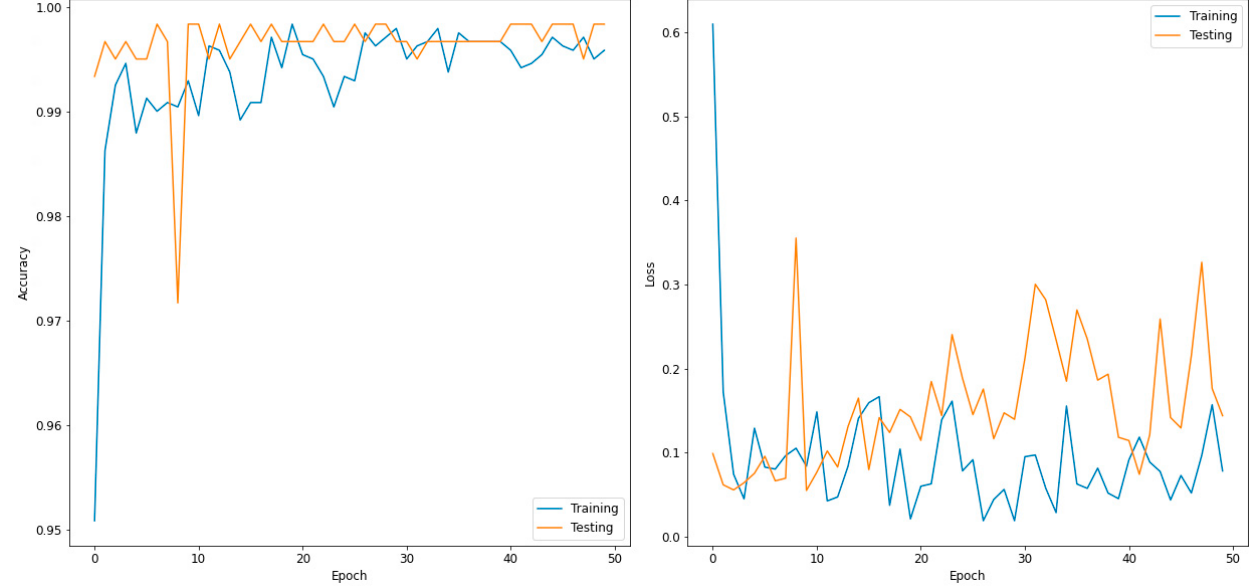
Figure 3. Accuracy ( left ) and loss curve ( right ) of DenseNet169 for two-class classifier. Table 6. Validation confusion matrix of DenseNet201 for three-class classifier.